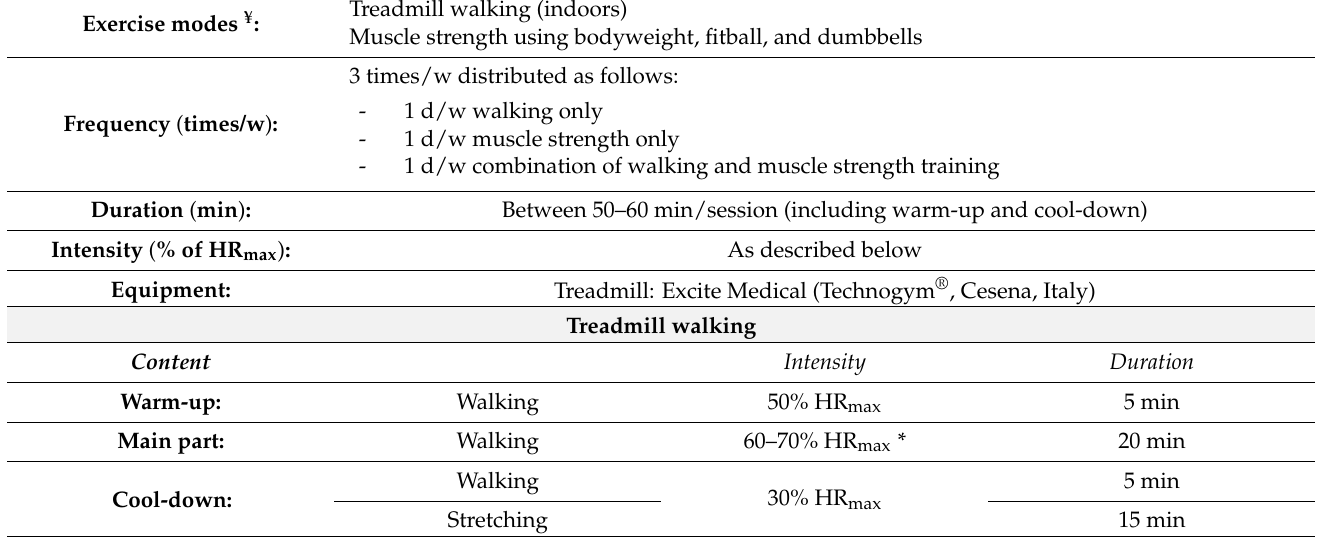
Table 3. Mixed-exercise arm